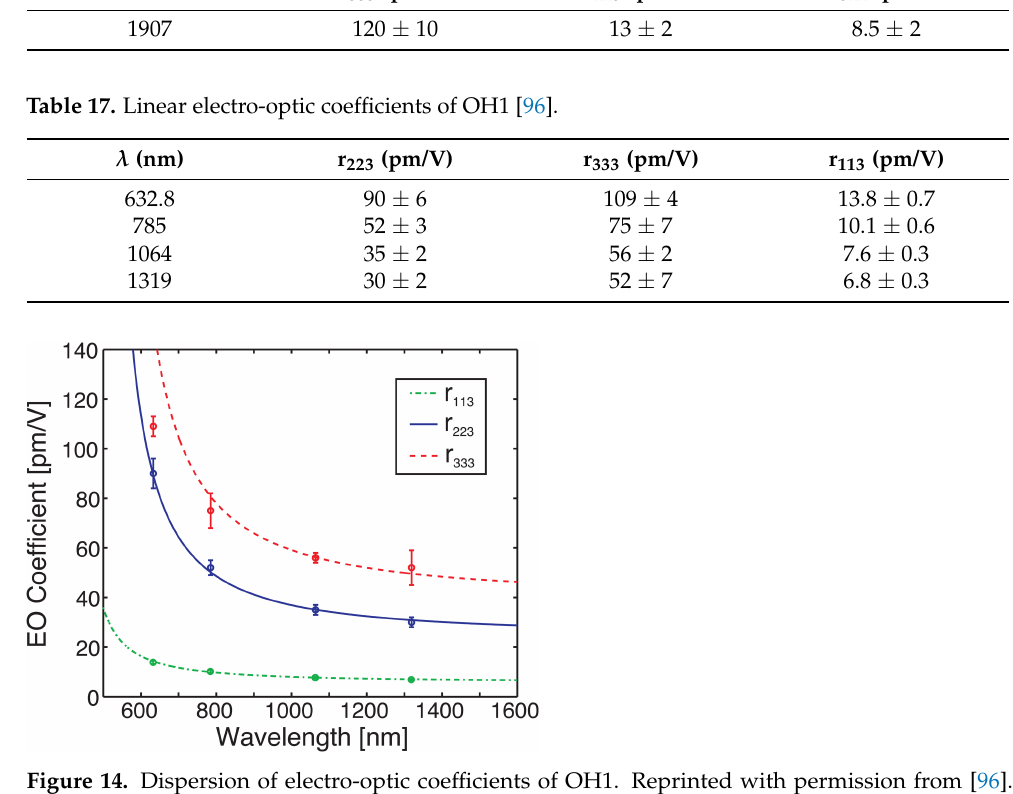
Figure 14. Dispersion of electro-optic coefficients of OH1. Reprinted with permission from [96]. © The Optical